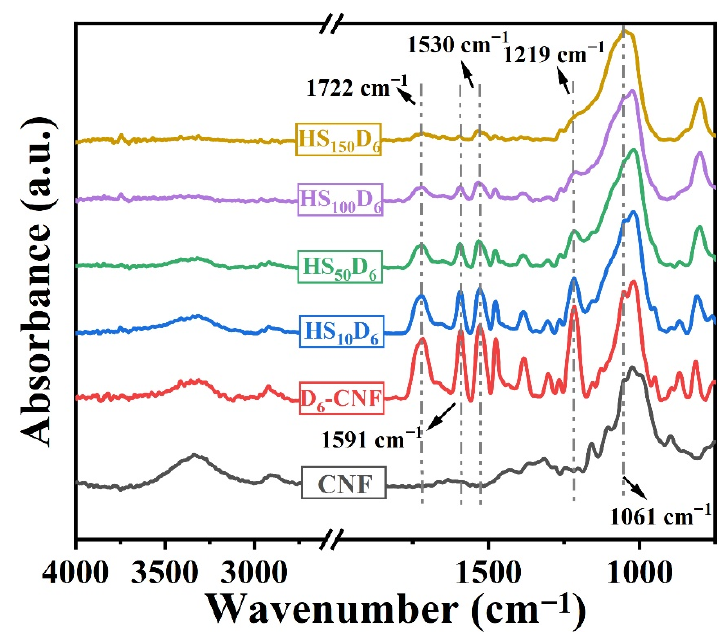
Figure 2. FTIR spectrum of CNF and HS n D 6 films.